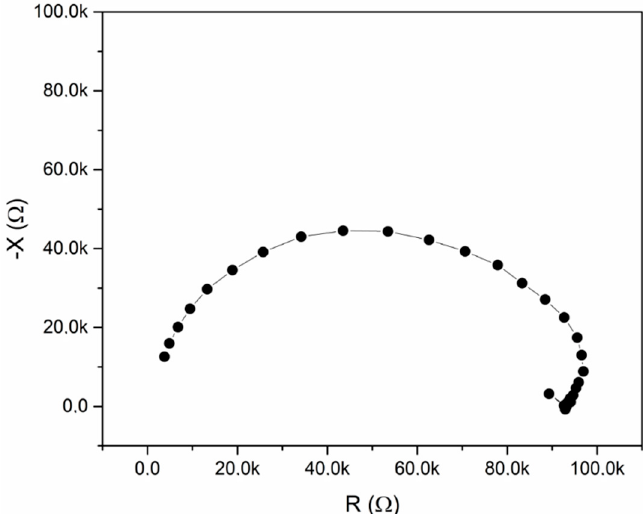
Figure 11. Nyquist plot of the Biochar sample in which charge transfer phenomenons are evident because of the broadened semi-circle.